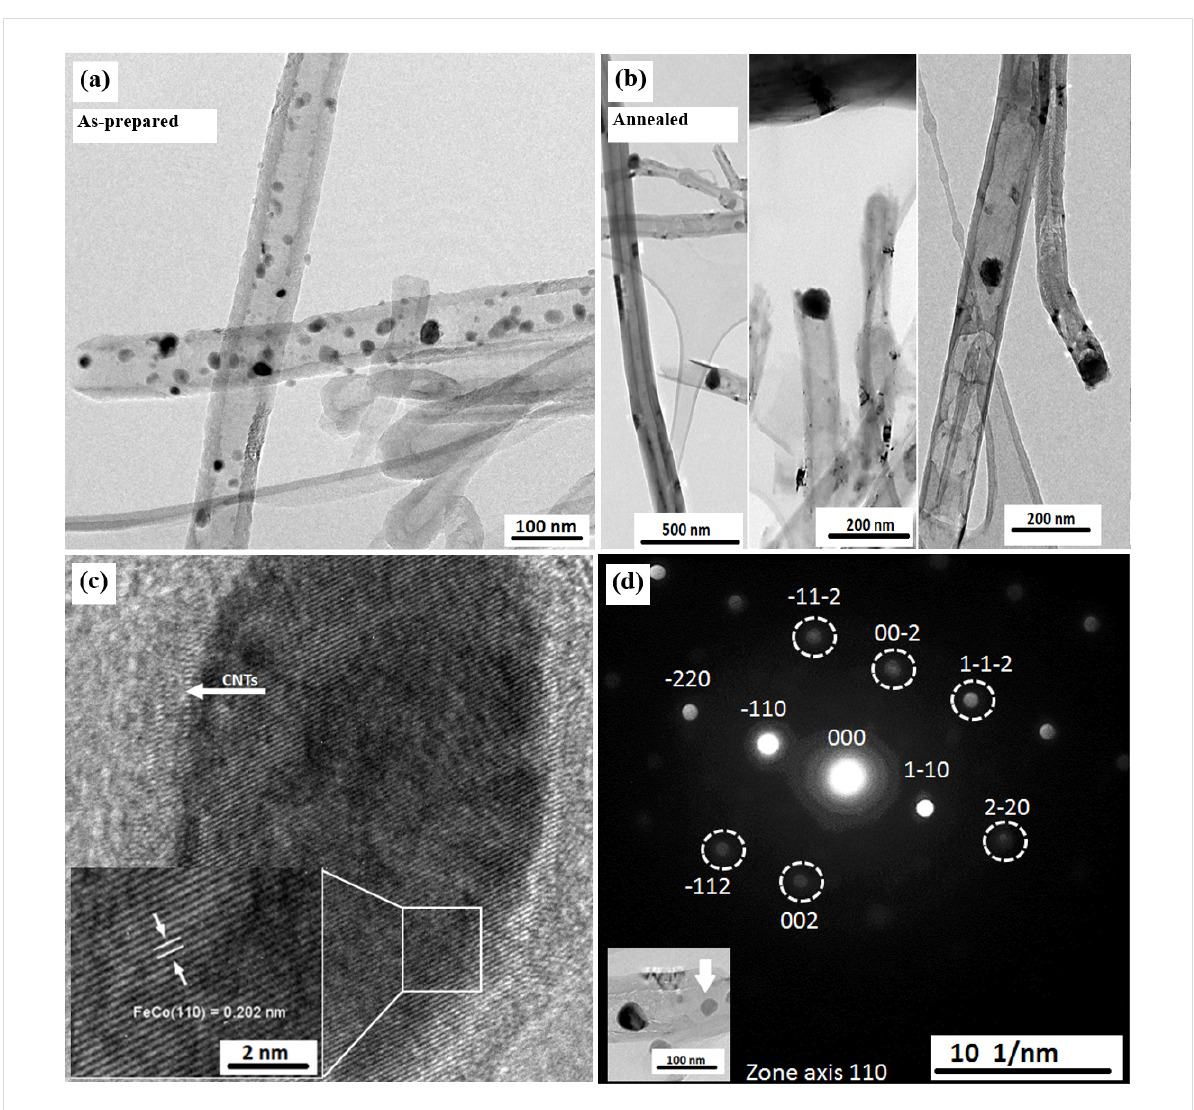
Figure 3: TEM bright field images for the a) as-prepared and b) annealed samples of Fe 50 Co 50 @CNT prepared by the second filling approach. c) HRTEM images for the as-prepared sample with the corresponding lattice fringes detailed in the inset, and d) nanobeam electron diffraction patterns of Fe 50 Co 50 nanoparticles with the corresponding TEM image as